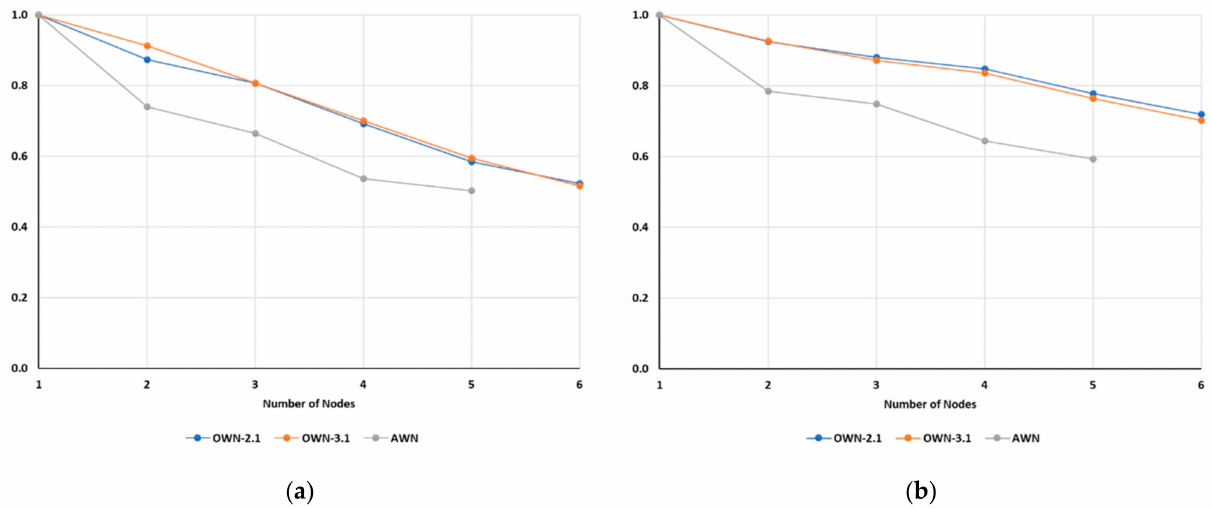
Figure 6. Efficiency with respect to the number of multi-nodes in the ALC and OCI for ( a ) small and ( b ) large